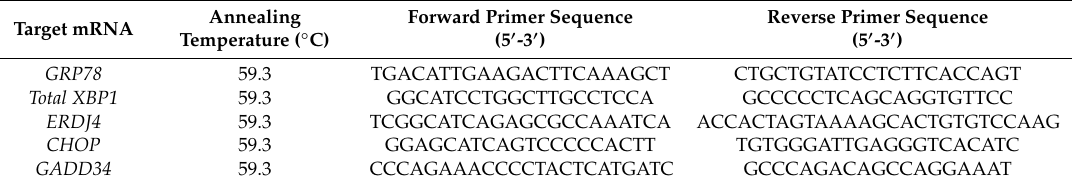
Table 2. The sequences and annealing temperature of endoplasmic reticulum stress-associated primers. Target